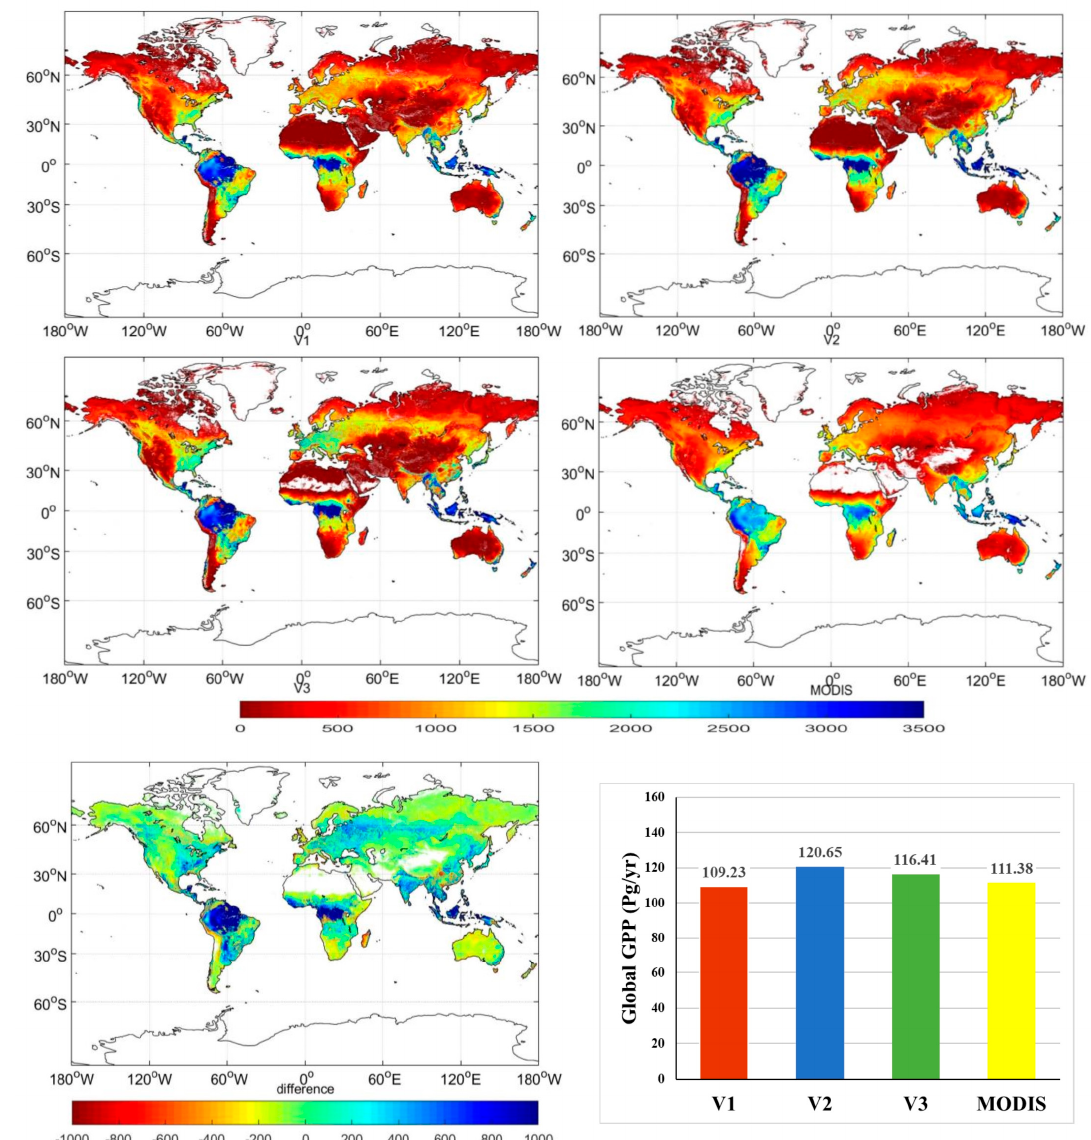
Figure 8. The distribution of Annual GPP (gC/m 2 /yr) produced by parameterization approach without the CI (left upper), parameterization approach with the CI (right upper), Cubist regression tree approach (left middle), and MOD17 GPP in 2014 (right middle), the difference between V2 and MOD17 GPP (left lower), and the histogram of global annual GPP in 2014 by four algorithms (right lower).